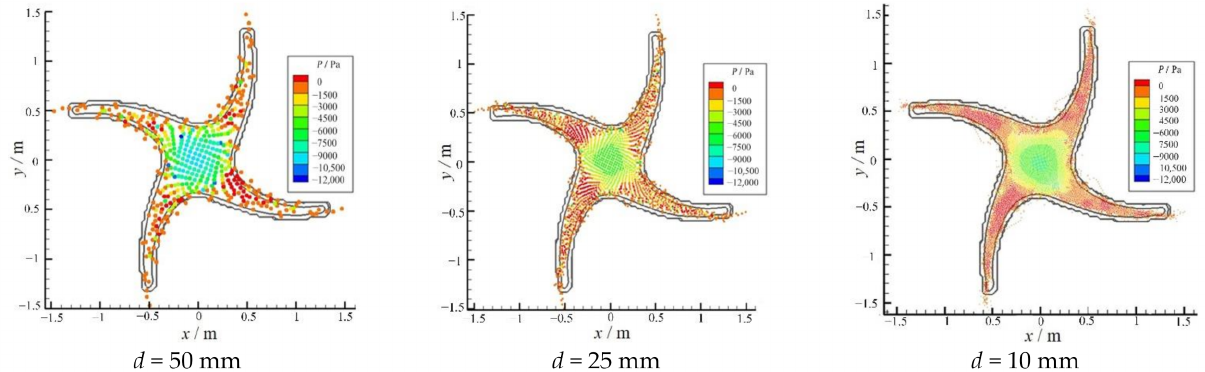
Figure 3. Comparison of the deforming process of Case 5 between the Moving Particle Semi-implicit (MPS) method (points) and the Volume of Fluids (VOF)